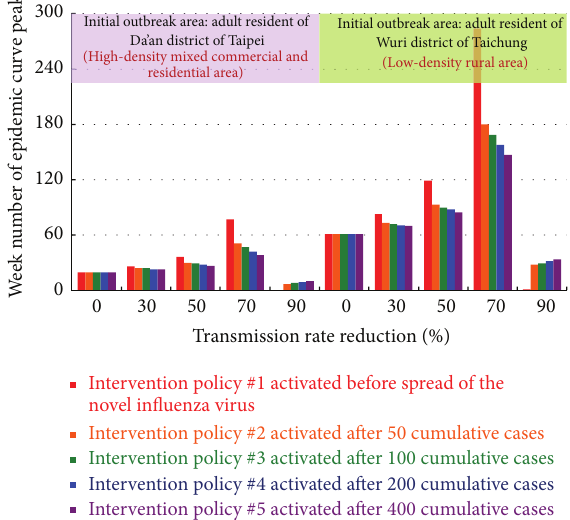
Figure 13: Epidemic peak week numbers for Taipei urban and Taichung rural